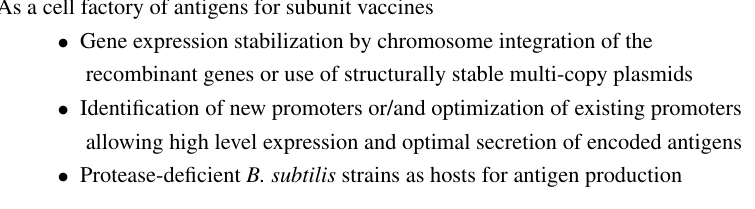
Improving the use of B. subtilis as a tool for vaccine development. As a cell factory of antigens for subunit